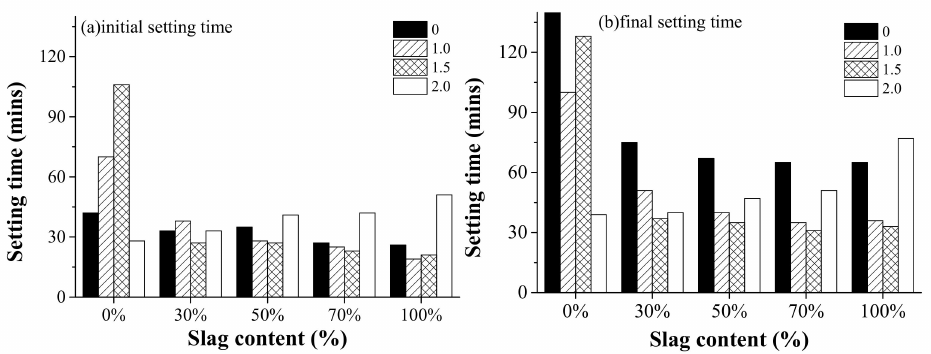
Figure 4. The e ff ect of the activator modulus (0, 1.0, 1.5, 2.0) and the slag content (0%, 30%, 50%, 70%, and 100%) on ( a ) the initial setting time and ( b ) final setting time of alkali-activated fly ash / slag (AAFS)